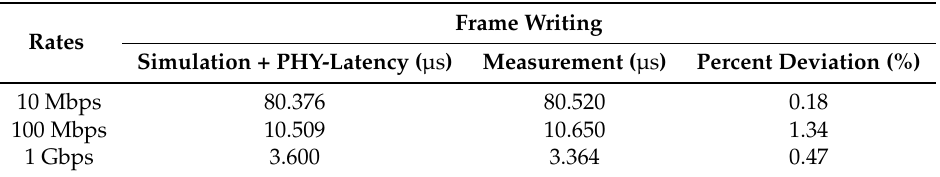
Table 5. Simulation data vs. measurement.